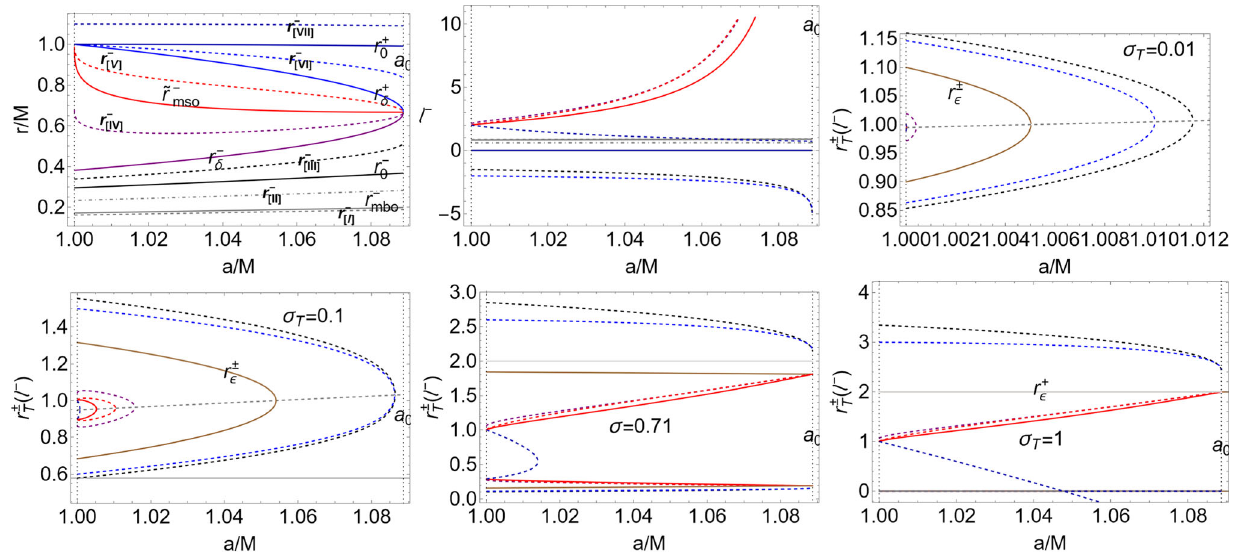
Fig. 3 Analysis of the flow inversion point radius r ± (cid:2) for differ- ent planes σ ≡ sin 2 θ signed on the panels, in the spin range is a ∈ [ M , a 0 ] , with fluid specific angular momentum (cid:6) = (cid:6) − . Radii r − mso = {¯ r − mso , ˜ r − mso } are the marginally stable orbit, radius r mbo is the marginally bounded orbit. There is r ± particle angular momentum and r ± δ : E = 0 where E is the test par- ticle energy. Left panels show radii r / M as functions of the NS spin a / M . Center panels show the fluid specific angular momentum (cid:6) − , evaluated on the left panel radii, as function of a / M . Right panels: